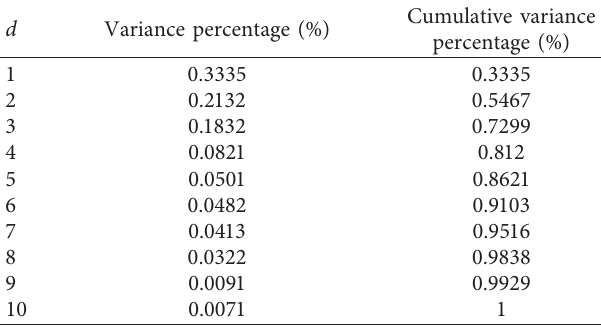
Table 4: Contribution percentage of the principal